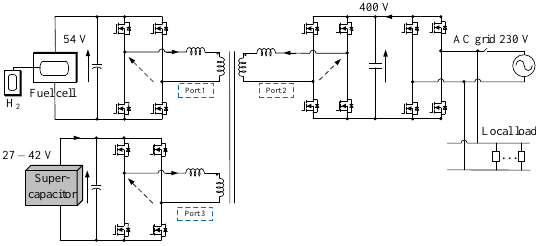
Figure 15. TAB converter in line-interactive UPS using fuel cell and supercapacitor application.